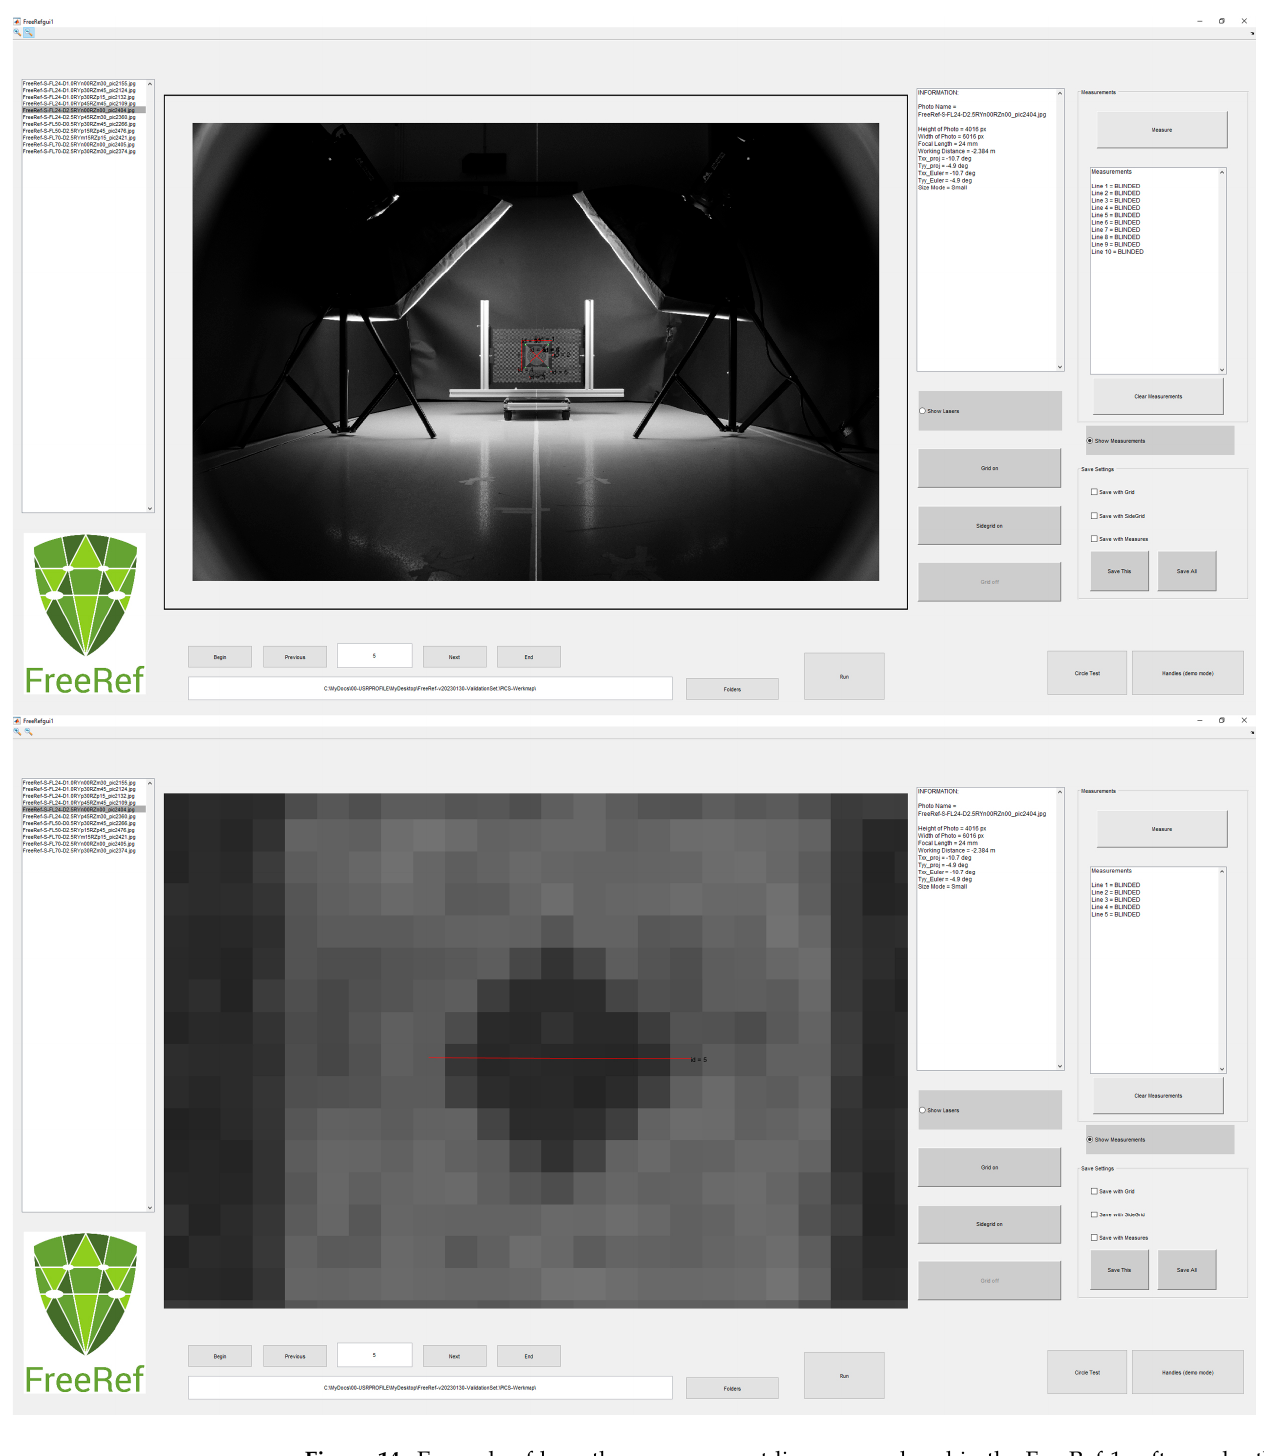
Figure 14. Example of how the measurement lines were placed in the FreeRef-1 software by the assistants. ( Top ) Interface with photo entirely zoomed out and all 10 veri fi cation line measurements assistants. ( Top ) Interface with photo entirely zoomed out and all 10 verification line measurements shown. ( Bo tt om ) Interface with photo zoomed in to measure veri fi cation line number 5, showing shown. ( Bottom ) Interface with photo zoomed in to measure verification line number 5, showing the the challenge of targeting the correct corners of the square. challenge of targeting the correct corners of the